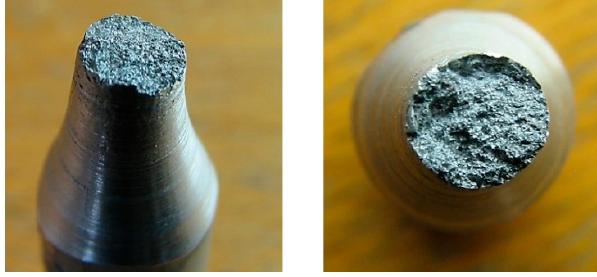
Figure 13. Macrostructure of the fracture area with gamma-geometry of the weld surface.